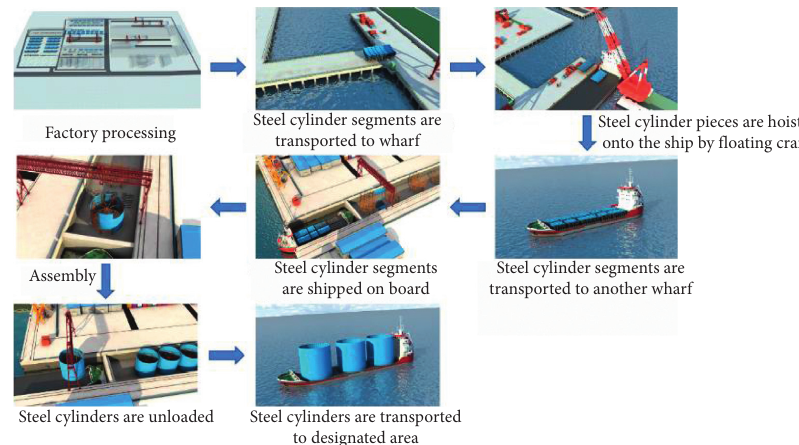
Figure 7: Production and transportation process of steel cylinders.